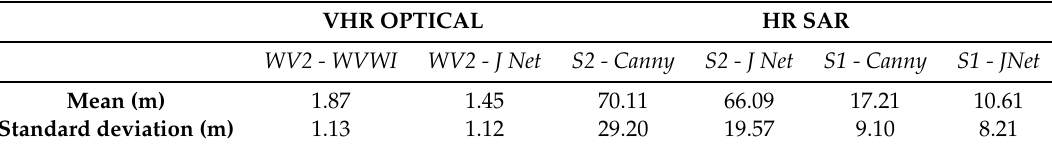
Table 3. Statistic table. The means and the standard deviations have been calculated on the difference between the reference shorelines with the algorithms we tested. The difference has been calculated on the values obtained from the intersection between the transects and the seven